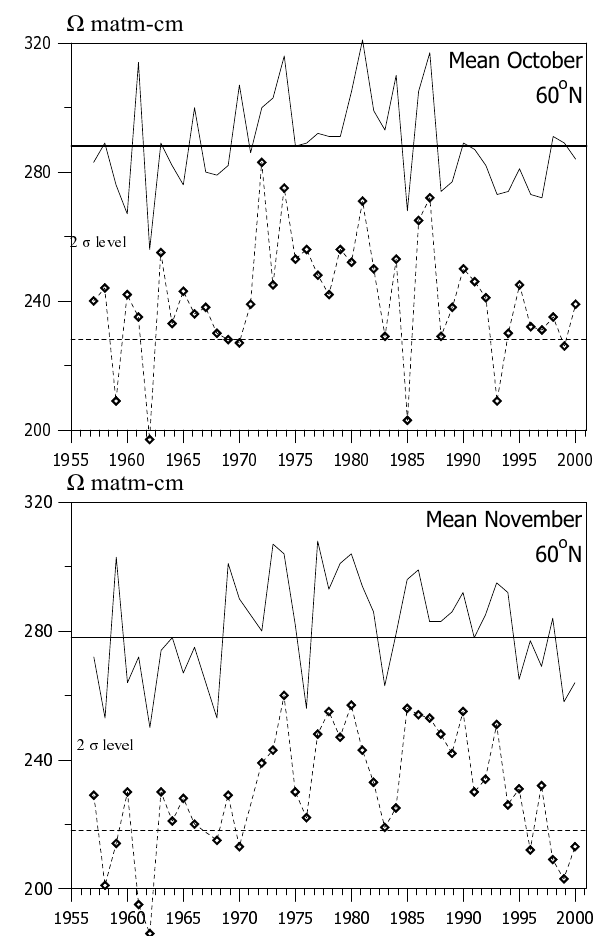
Fig. 3. Monthly mean October (upper panel) and November (Lower FIGURE 2 panel) total ozone values for the years 1957–2000 from ground- based stations around 60 ◦ N (solid line). The dashed line shows the 2 σ levels of the daily values and the diamonds indicate the mini- mum values